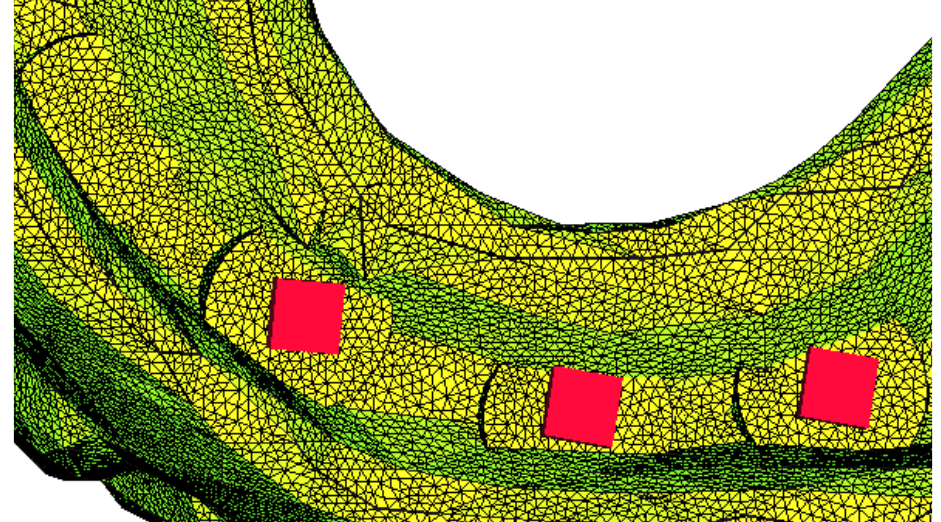
Figure 3. Locking on the surface of three out of four implants.